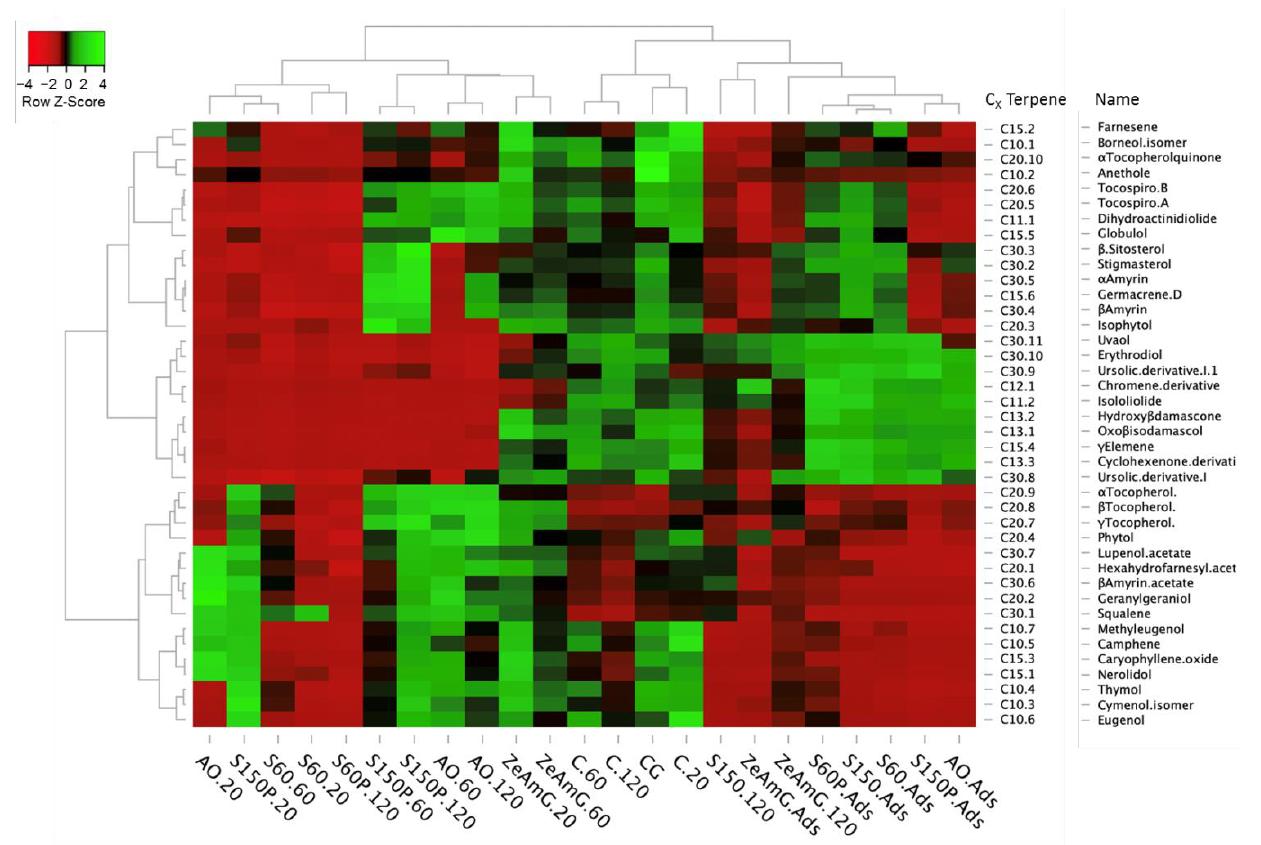
Figure 7. Heatmap showing the differential enrichment of identified terpenoid compounds (P1–P40) in olive leaves extracts and adsorbates obtained by SFE. Color code: light green (higher enrichment); light red (lower enrichment).